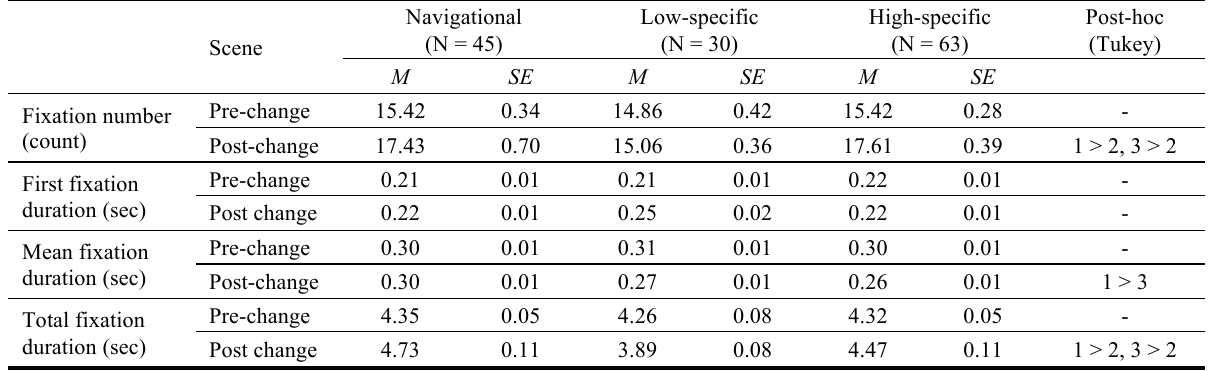
Table 1. Mean and Standard Error in each intention condition for each DV